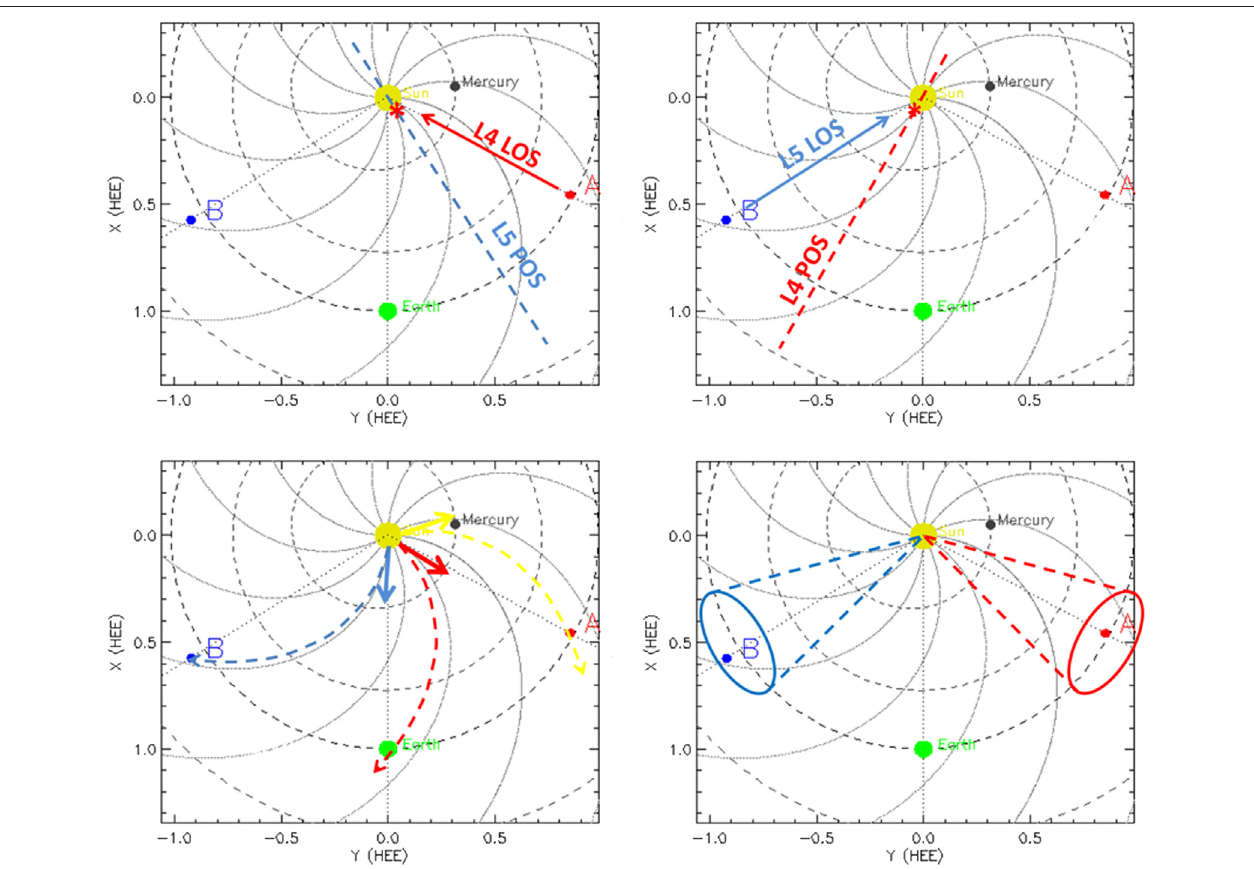
FIGURE 2 | Example of possible advantages offered by the twin L4-L5 mission proposed here. Top panels: the plane-of-sky (POS) of remote sensing instruments will allow to observe limb events from one spacecraft that will be observed as events at the center of solar disk from the other spacecraft. Bottom left : combinations of remote sensing and in situ data will allow to study CMEs propagating at different direction (blue, red, and yellow arrows) and also to sample the associated SEP fl uxes propagating along theParker spiral arms (blue, red, and yellow dashed lines). Bottom right : during their Trojan stableorbits around L4 and L5 the twin spacecraft willgofromrelativequadraturetoquasi-quadraturewiththeEarth(dashedlines).ThesedrawingsarebasedontheplotprovidedbytheSTEREOorbittool 2 andshowing the location of STEREO spacecraft when the mission passed nearby L4 and L5 points (October